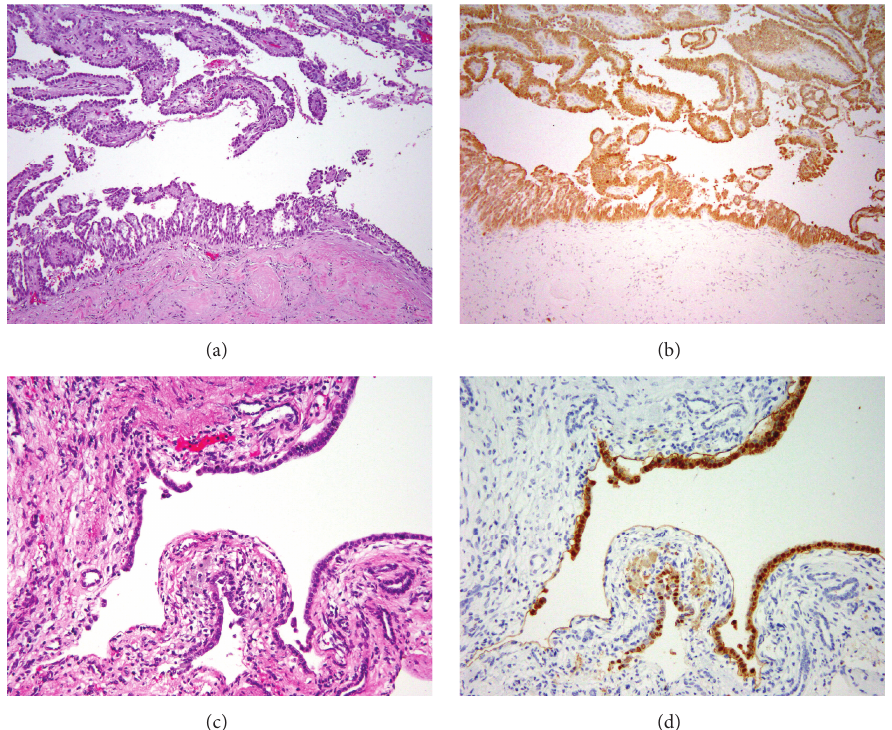
Figure 3: (a) H&E stained slide of a cystic component of the right confirmed papillary type 2 renal cell carcinoma. (b) 2SC stained slide of the right confirmed papillary type 2 renal cell carcinoma. (c) H&E slide of the left benign cystic renal lesion. (d) 2SC stained slide of left benign cystic renal